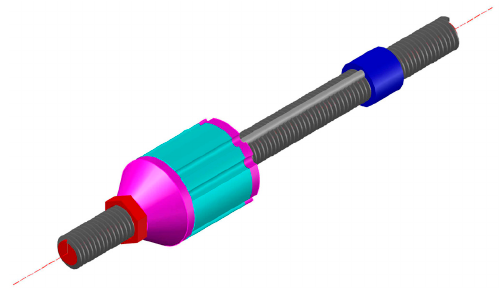
Figure 24. Photo of the Smart Rockbolt [72].